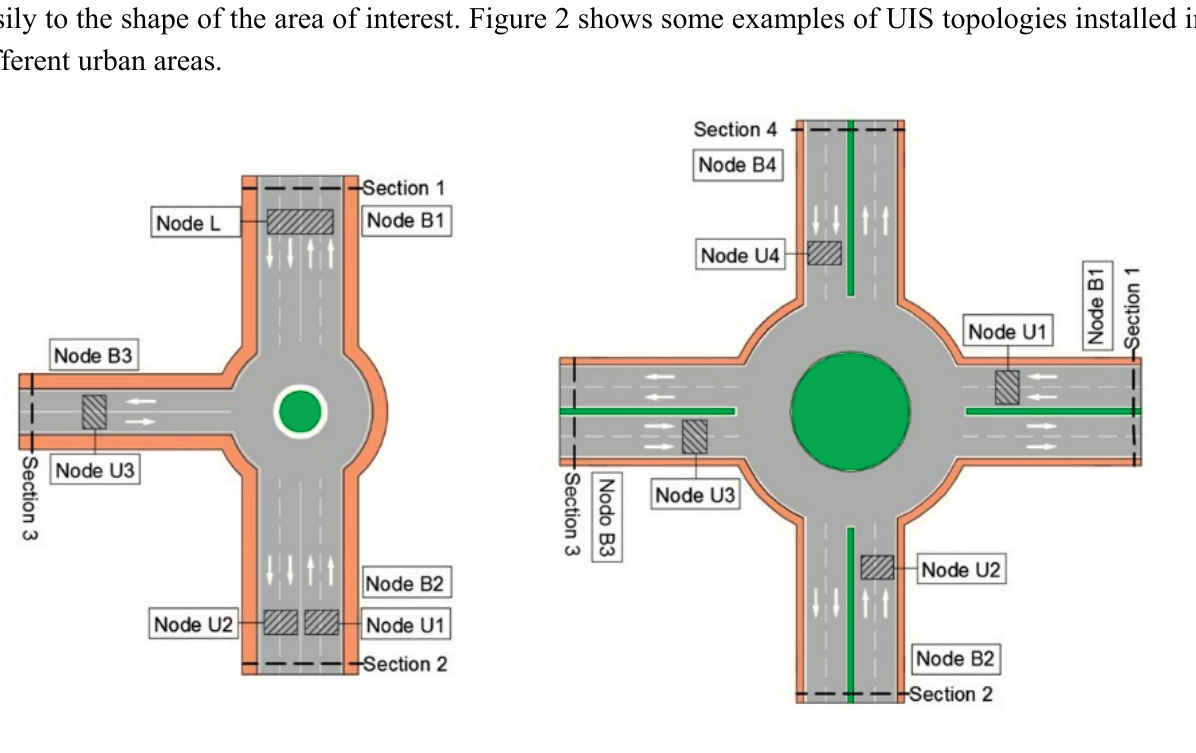
Figure 2. UIS deployment